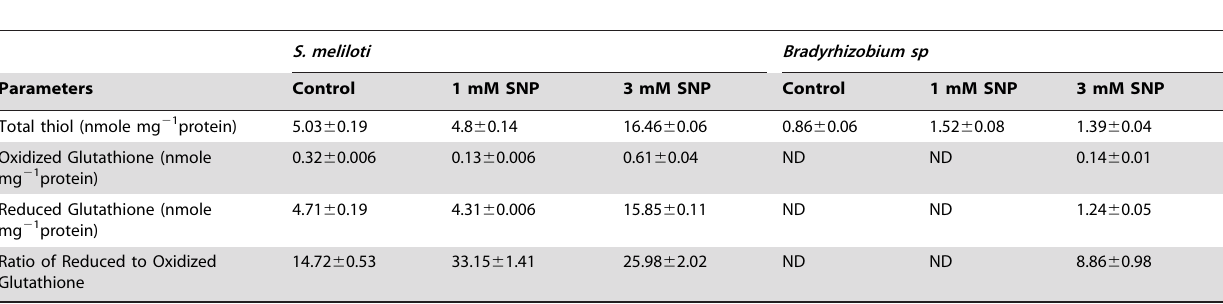
Table 2. Quantification of thiol pool in S. meliloti 1021 and Bradyrhizobium sp after 30 minute stress with SNP in media.